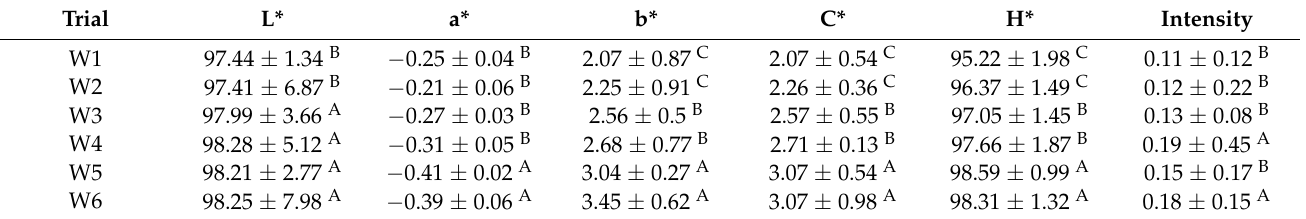
Table 3. Effect of S. cerevisiae RT73 and Starm. bacillaris CZ31 strains and oak chips on the chromatic characteristics of Trebbiano d’Abruzzo